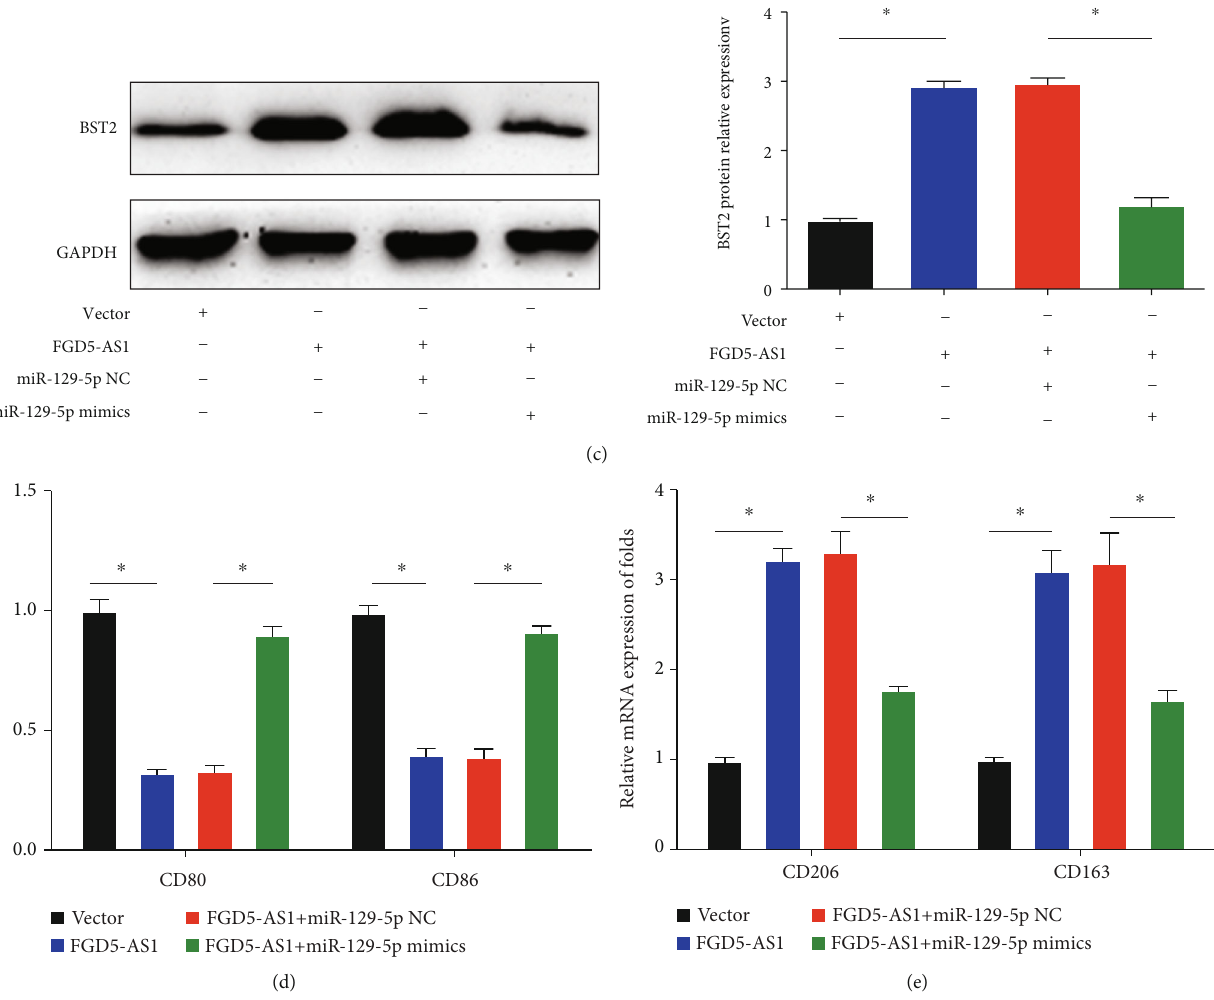
Figure 6: miR-129-5p mimics reversed FGD5-AS1-induced upregulation of BST2 and M2 macrophage polarization. (a) Levels of FGD5- AS1 in SiHa cells transfected with vector, FGD5-AS1, FGD5-AS1 plus miR-129-5p NC, or FGD5-AS1 plus miR-129-5p mimics. (b, c) The levels of BST2 in SiHa cells. (d) mRNA expression of CD80 and CD86 in macrophages. (e) mRNA expression of CD206 and CD163 in macrophages. ∗ P < 0 : 05 . Three independent assays were carried